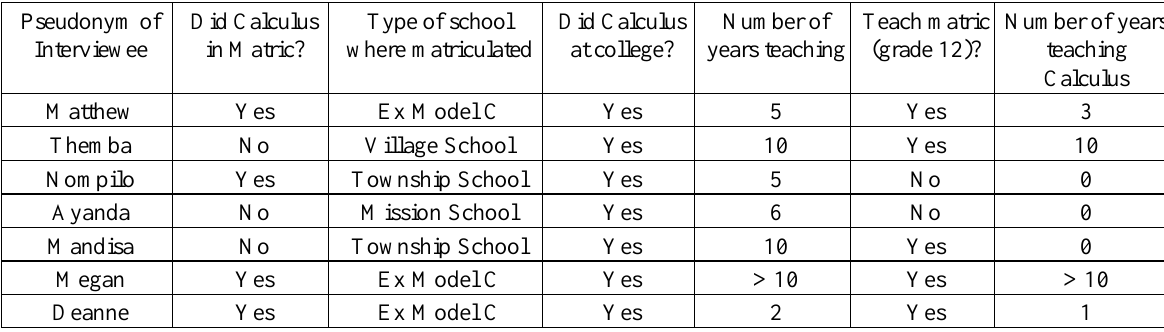
Table 1: The background and current situation of interviewees Pseudonym of